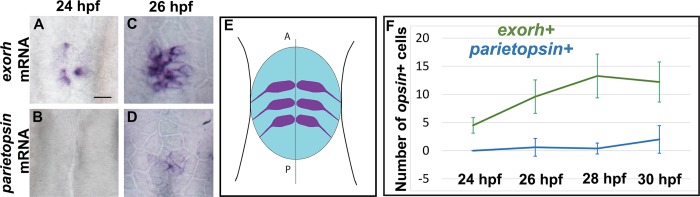
Expression of exorh and parietopsin follows a temporal sequence.(A-D) In situ hybridization for exorh or parietopsin at 24 and 26 hpf. At 26 hpf, only 2 out of 10 embryos showed parietopsin+ cells; in these embryos, parietopsin expression is restricted to the center of the pineal territory. (E) Schematic representation showing the pineal territory in blue and nascent neurons in purple, indicating the orientation of the images in (A-D); dorsal view with the anterior to the top. (F) Counts of exorh+ and parietopsin+ cells in embryos of various stages, which are indicated on the x-axis. Error bars represent SD. Number of embryos analyzed are n = 6, 5, 11, and 5 for exorh+ cells at 24, 26, 28, and 30 hpf, respectively, and n = 10, 10, 21, and 5 for parietopsin+ cells at the same stages. Scale bar represents 15 μm. Underlying data can be found in S1 Data. exorh, exorhodopsin; hpf, hours post fertilization.